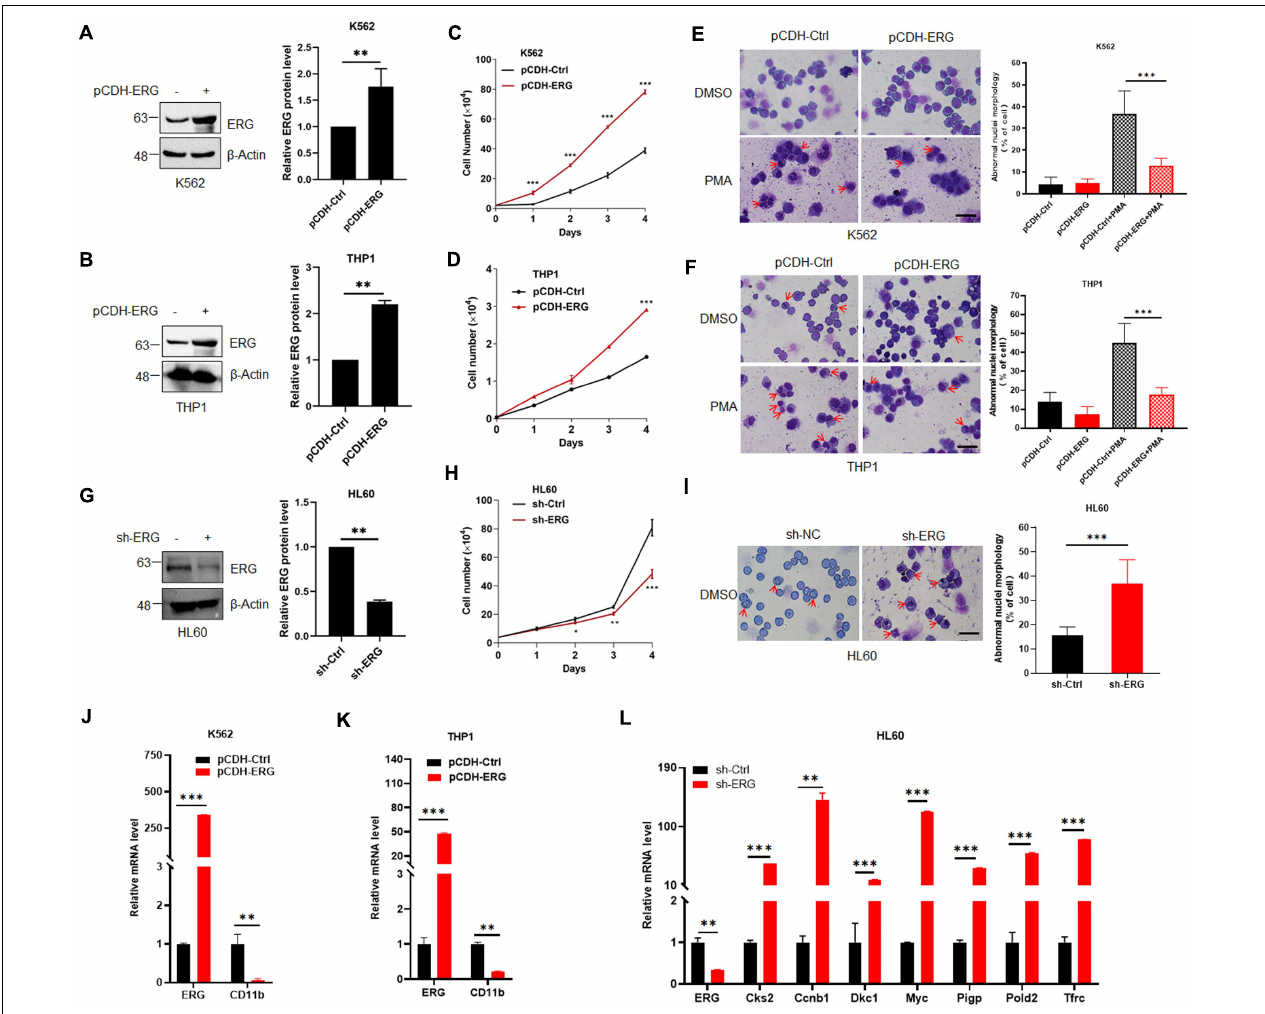
FIGURE 2 | ETS-related gene promotes myeloid leukemia cell proliferation and inhibits cell differentiation. (A,B) ERG was stably transfected into K562 (A) and THP1 (B) cells. pCDH-ERG or control lentivirus was transfected into K562 and THP1 cells, and the cell lysates of stably constructed cells were detected by IB with anti-ERG and anti- β -Actin antibodies (left). The results of quantitative analysis of Western blot are shown in the right panel ( n = 3 repeats/group, Student’s t -test, ** p < 0.01). (C,D) ERG overexpression promoted the proliferation of K562 (C) and THP1 (D) cells. Growth curves of ERG overexpression or control cells were constructed from daily quantification of cell numbers ( n = 3 repeats/group, one-way ANOVA, *** p < 0.001). (E,F) ERG overexpression inhibited the PMA induced differentiation of K562 (E) and THP1 (F) cells. ERG overexpression or control cells were treated with DMSO or PMA, and the cell differentiation was analyzed by Giemsa staining (left). The results of quantitative analysis of differentiated cells are shown in the right panel ( n = 3 repeats/group, two-way ANOVA, *** p < 0.001). The scale bar is 100 µ m. (G) ERG was stably knockdown in HL60 cells. sh-ERG or control lentivirus was transfected into HL60 cells, and the cell lysates of stably constructed cells were detected by IB with anti-ERG and anti-( β -Actin antibodies (left). The results of quantitative analysis of Western blot are shown in the right panel ( n = 3 repeats/group, Student’s t -test, ** p < 0.01). (H) ERG knockdown inhibited the proliferation of HL60 cells. Growth curves of ERG knockdown or control cells were constructed from daily quantification of cell numbers ( n = 3 repeats/group, one-way ANOVA, * p < 0.05, ** p < 0.01, *** p < 0.001). (I) ERG knockdown promoted the differentiation of HL60 cells. ERG knockdown or control cells were cultured and the cell differentiation was analyzed by Giemsa staining (left). The results of quantitative analysis of differentiated cells are shown in the right panel ( n = 3 repeats/group, Student’s t -test, *** p < 0.001). The scale bar is 100 µ m. (J,K) The mRNA level of CD11b was decreased after ERG overexpression in K562 (J) and THP1 cells (K) . The expression levels of ERG and CD11b transcripts in pCDH-ERG stably transfected cells were measured by real-time PCR and normalized to pCDH-Ctrl cells ( n = 3 repeats/group, two-way ANOVA, ** p < 0.01, *** p < 0.001). (L) The mRNA level of ERG target genes was increased after ERG knockdown in HL60 cells. The expression levels of ERG and target genes transcripts in sh-ERG stably transfected HL60 cells were measured by real-time PCR and normalized to sh-Ctrl cells ( n = 3 repeats/group, two-way ANOVA, ** p < 0.01, *** p < 0.001).